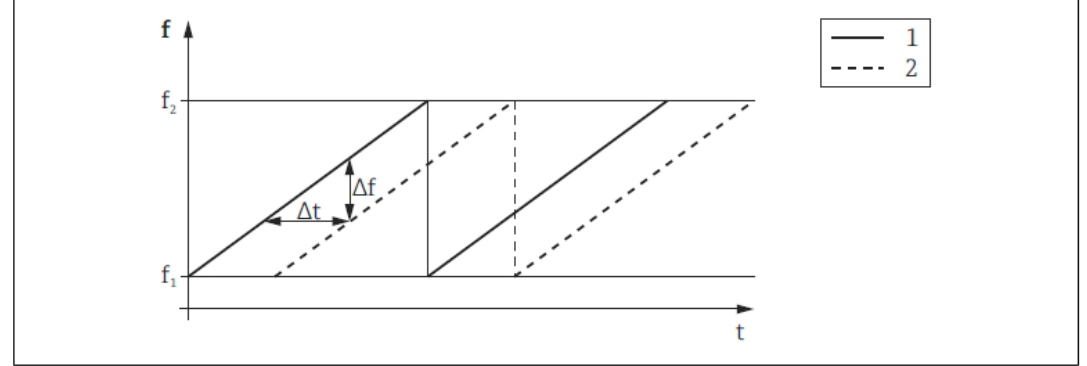
Figure 25. FMCW radar measurement principle.